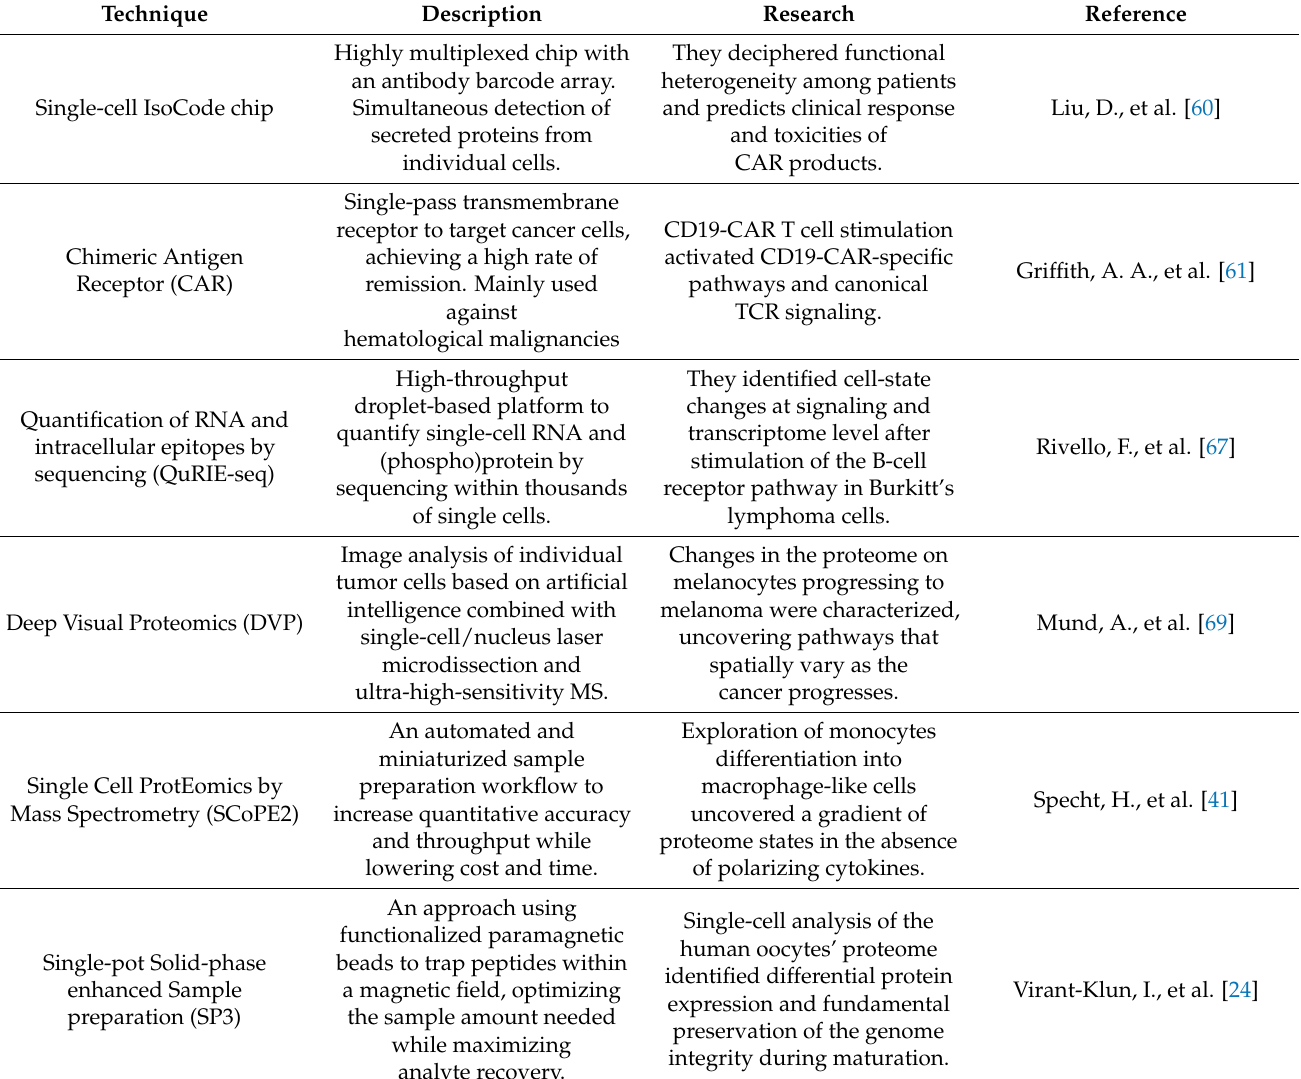
Table 3. Recent works in single-cell